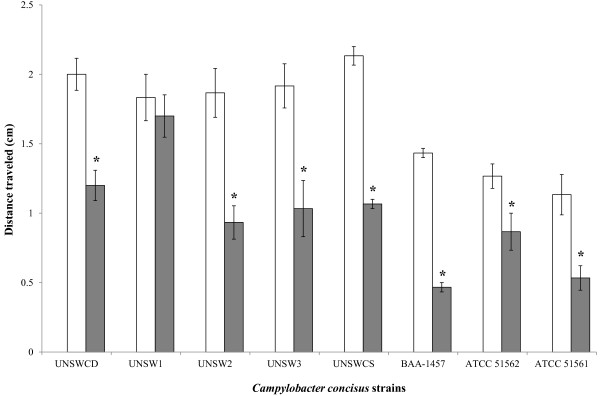
The motility of Campylobacter concisus strains following growth in liquid (white) and 20 cp viscous liquid (gray) medium. Vertical lines associated with histogram bars represent standard error of the mean. * implies p<0.05.